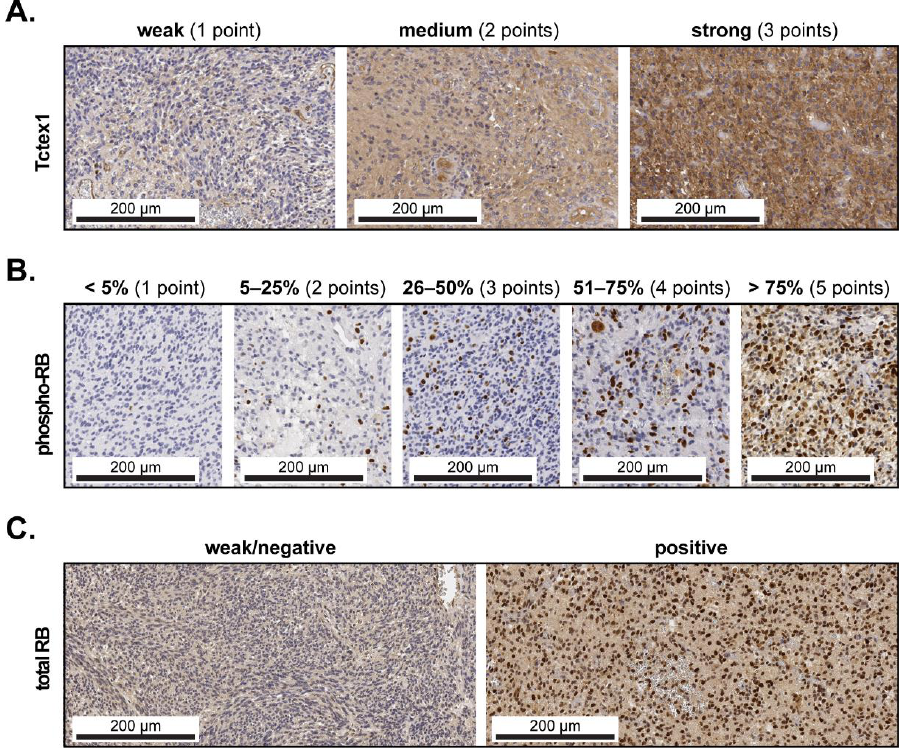
Figure 1. Marker expression and scoring in GBM tissues. ( A ) Representative micrographs showing weak (1 point), medium (2 points) and strong (3 points) expression of Tctex1 in GBM tissues. The H-score was subsequently calculated according to the formula: (1 × X) + (2 × Y) + (3 × Z), where X + Y + Z = 100% of the total tumor area. Representative micrographs showing ( B ) the 5-tier score for phospho-RB according to the percentage of positive cells and ( C ) weak/negative or positive staining for total RB. The scale bars are indicated in the lower-left corner of each panel.